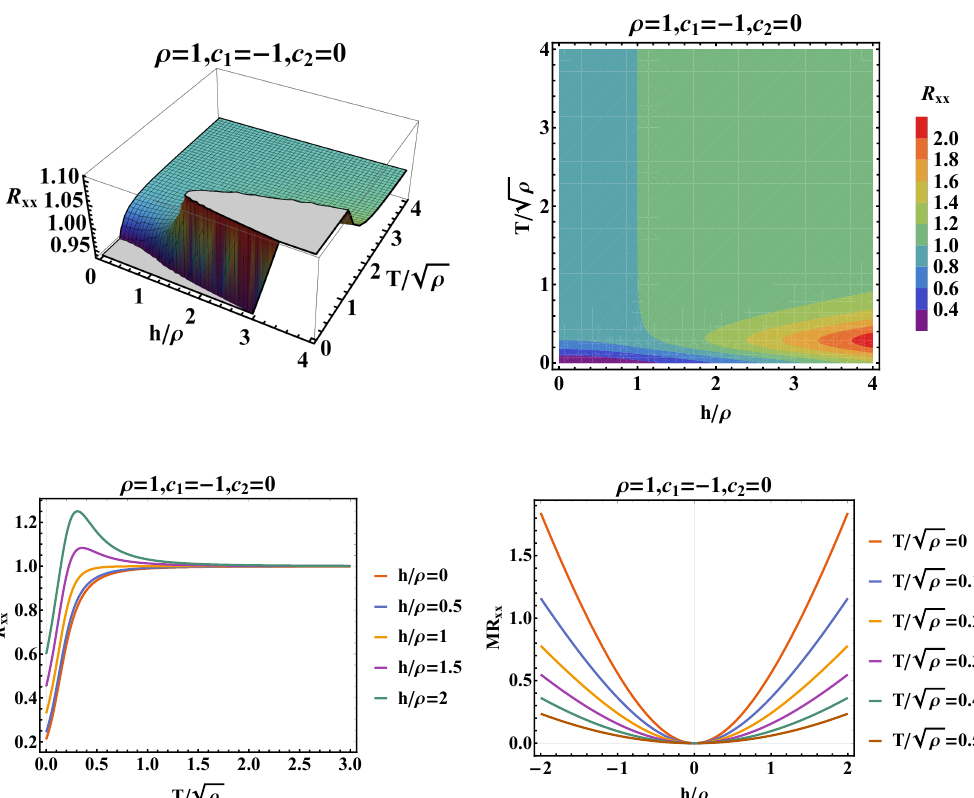
√ ρ . Upper right: contour plot of R xx .